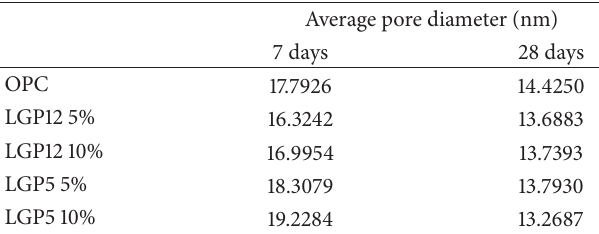
Table 6: Comparison of reduction average pore